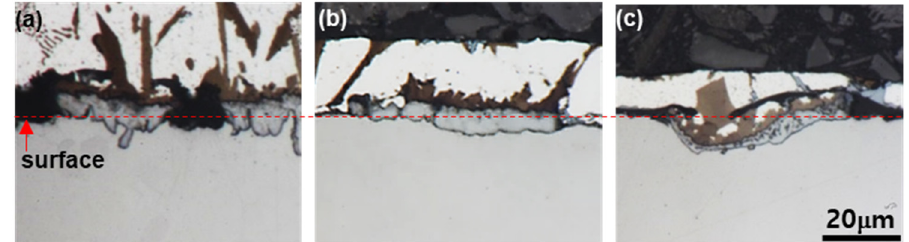
Figure 14. Cross ‐ sectional optical micrographs of specimens hot dipped at 690 °C for 40 s for depending on the amount of Si added based on Al–7Ni wt % coating: ( a ) 0 wt % Si, ( b ) 2 wt % Si, and ( c ) 6 wt % Si.